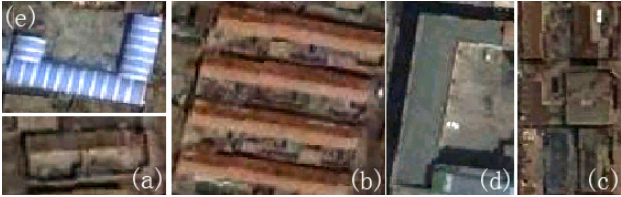
Figure 9 Different types of building’s structural